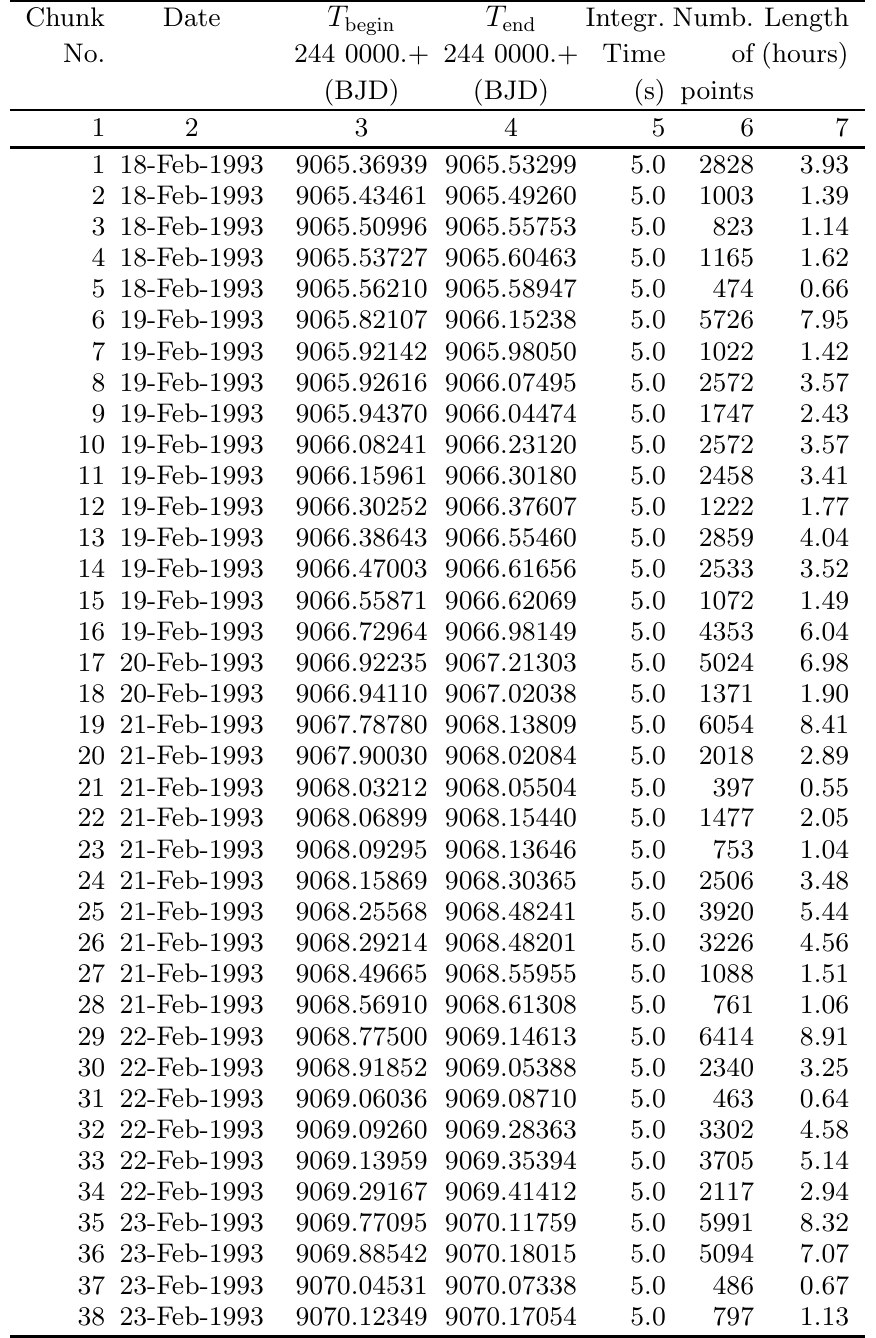
Table 2. Journal of observations of